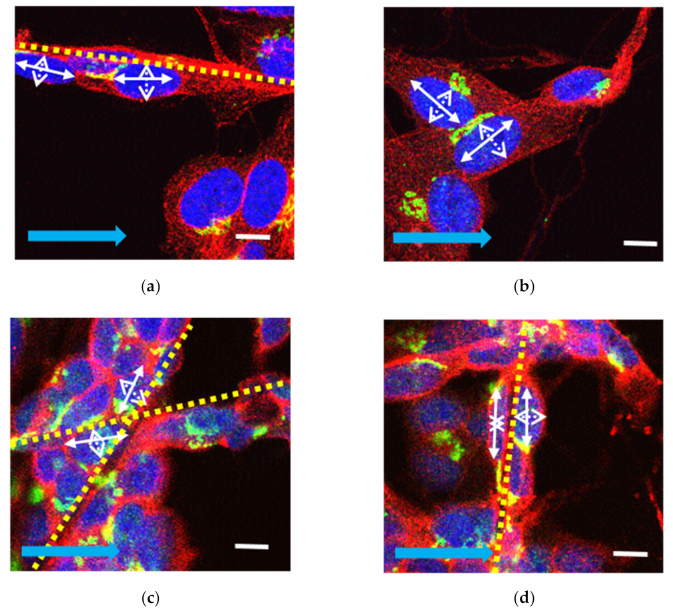
Figure 2. Examples of cells classified as aligned ( a ), flat ( b ), non-aligned ( c ), and perpendicular ( d ). Aligned cells lie on electrospun fibers also aligned with the EF direction ( a ), cells grown in between where fibers cross ( c ), and cells grown on aligned fibers orientated perpendicular to the direction of the EF ( d ). Major (long) and minor (short) axes of human SH-SY5Y cell nuclei are illustrated using a solid white arrow to represent the major (long) axis of the nucleus and a dashed white arrow, the minor (short) axis. Yellow dashed lines represent electrospun fibers. Solid blue arrow represents the direction of the EF. BDNF (green), β -tubulin (red), and DAPI (blue) (scale bar 10 µ m).